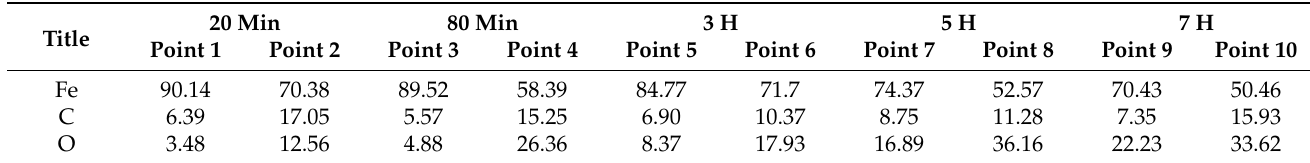
Table 3. The main elements and content in corrosion products at the light-gray area after different corrosion times